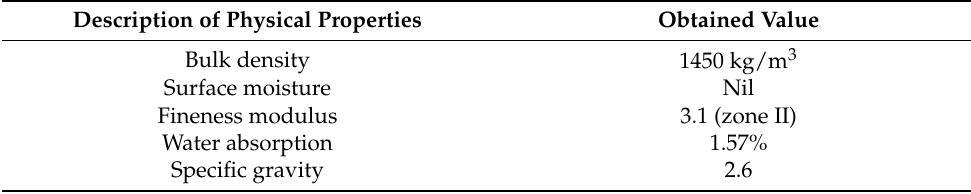
Table 1. Physical properties of Fine